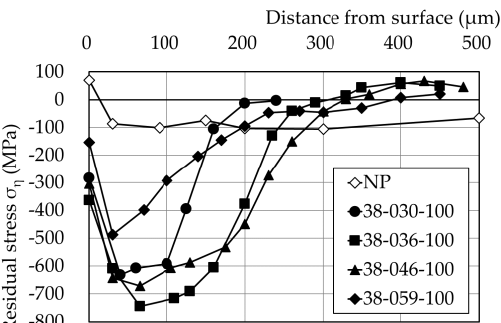
Figure 6. Residual stress depth distribution (38 mJ).